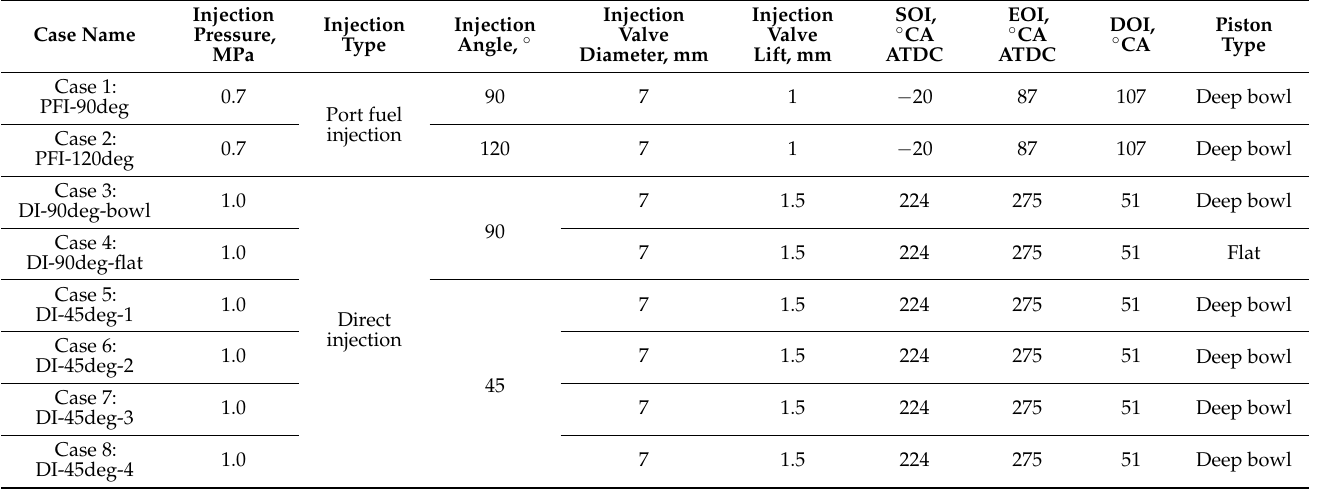
Figure 1. Layout of the 8 cases. Table 2. Parameters of each